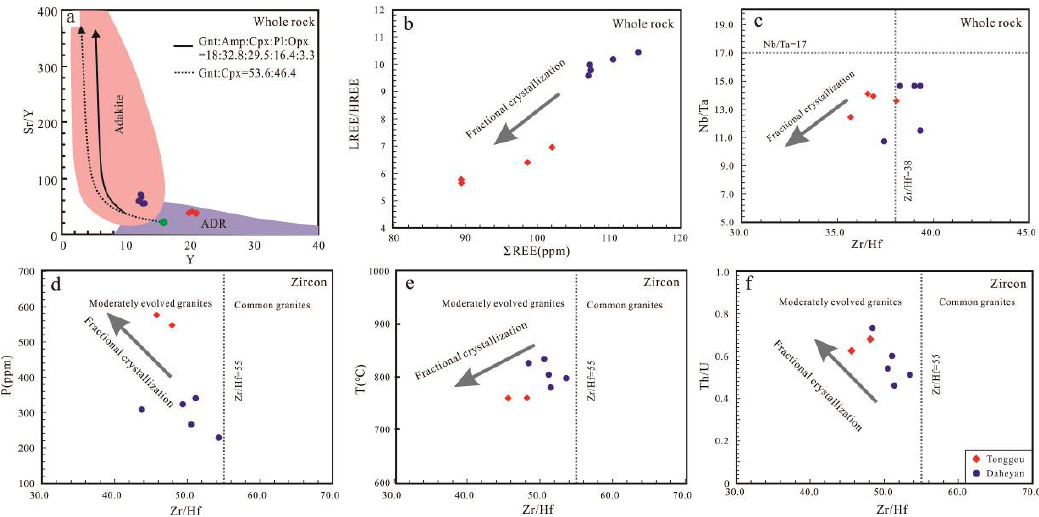
Figure 10. Geochemical characteristics of the Tonggou and Daheyan samples, which record a high degree of fractionation. ( a ) Sr/Y vs. Y in whole rocks [86]; ( b ) ΣREE vs. LREE/HREE in whole rocks; ( c ) Zr/Hf vs. Nb/Ta in whole rocks; ( d ) Zr/Hf vs. P in zircon; ( e ) Zr/Hf vs. T in zircon; ( f ) Zr/Hf vs. Th/U in zircon. Partial data for Daheyan granodiorite cited from [51]. Partial melting curves are calculated for accumulated fractional melting of lower crust, with starting values from [87]. ADR = island andesite-dacite-rhyolite.